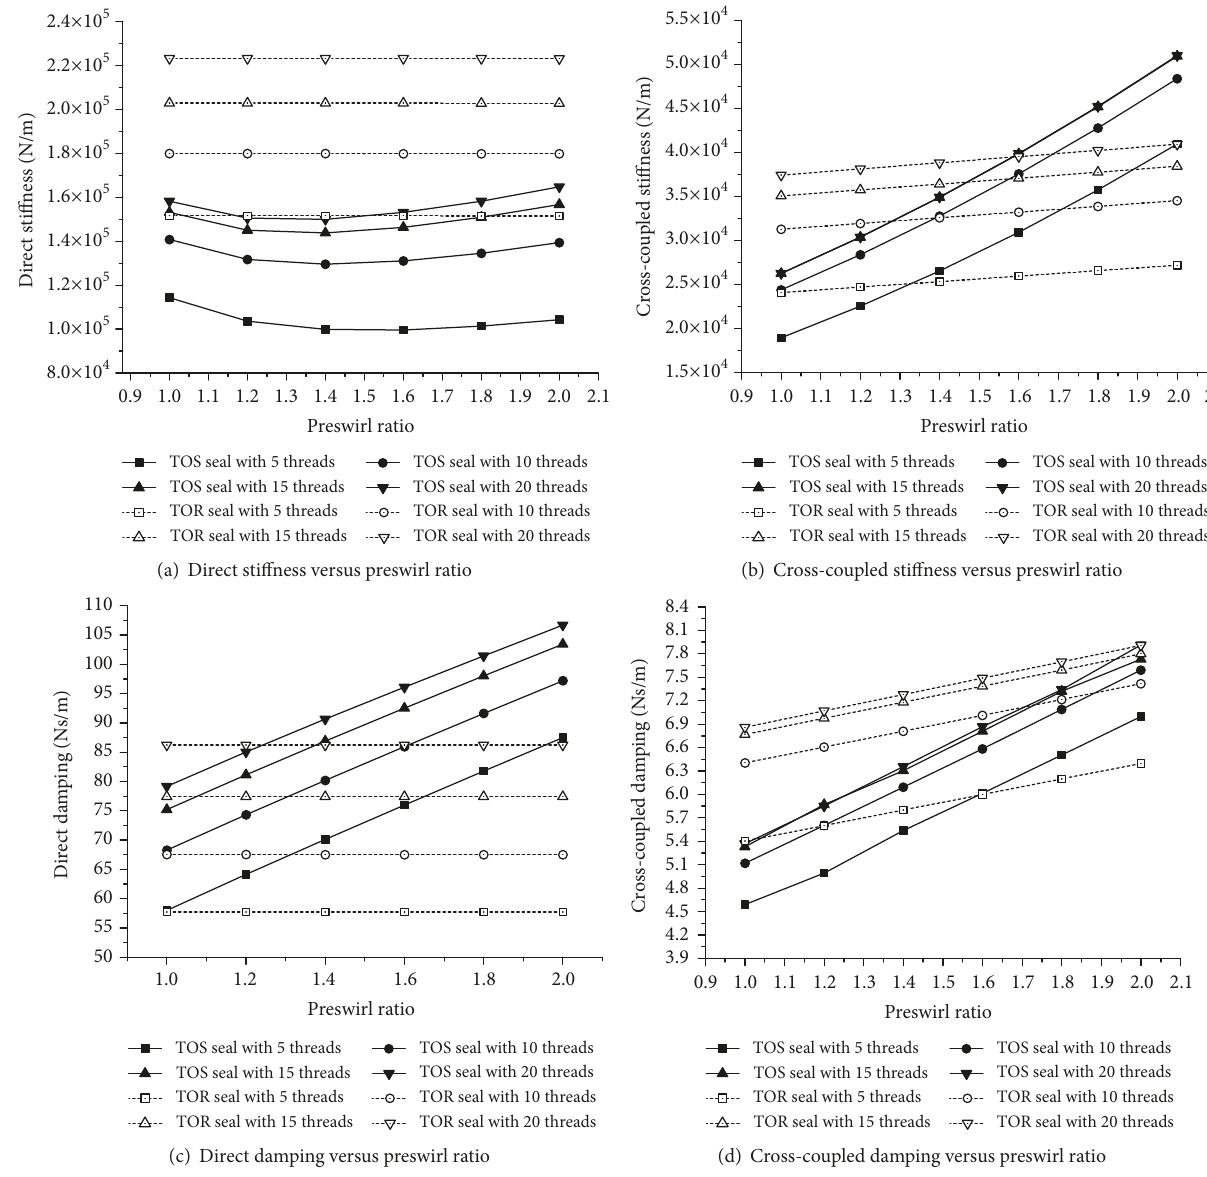
Figure 9: Dynamic characteristic changes of herringbone-grooved TOR and TOS seals with preswirl ratio. Table 3: Comparisons between predicted and measured resultant